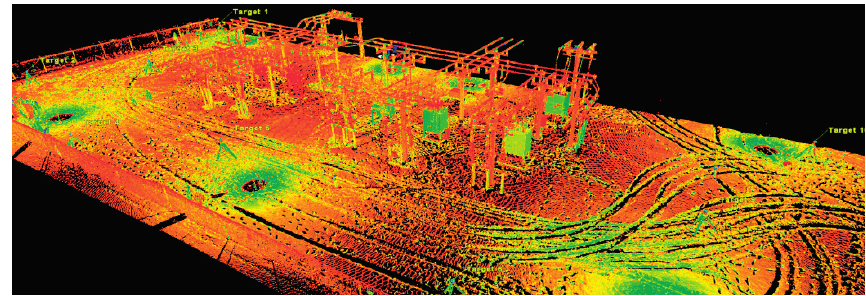
Figure 16. First dataset, scanned by a Leica HDS 6100 terrestrial laser scanner.